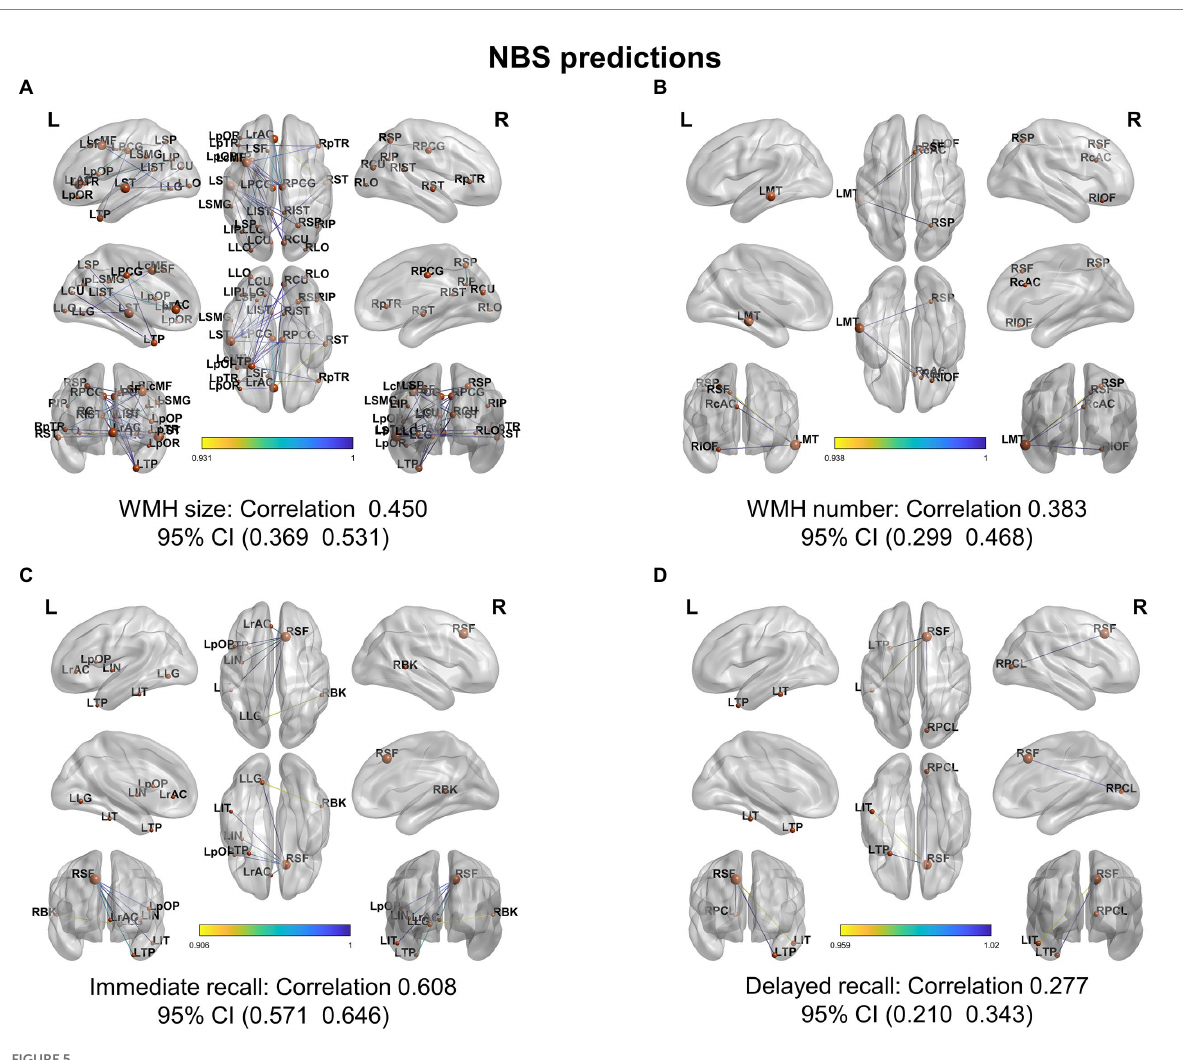
FIGURE 5 NBS classification. In patients with SACS, the NBS classification identifies both hyper-connected (upper panel) qqand hypo-connected (lower panel) subnetworks. Hyper-connected subnetworks (weight threshold = 0.9) in patients are depicted in (A) the suprathreshold adjacent matrix, (B) classification performance, (C) a graph visualized with the BrainNet Viewer (https://www.nitrc.org/projects/bnv/), and (D) the circular connectome. Edges in both figures, and nodes in the circular graphs are colored according to their weights and standardized nodal